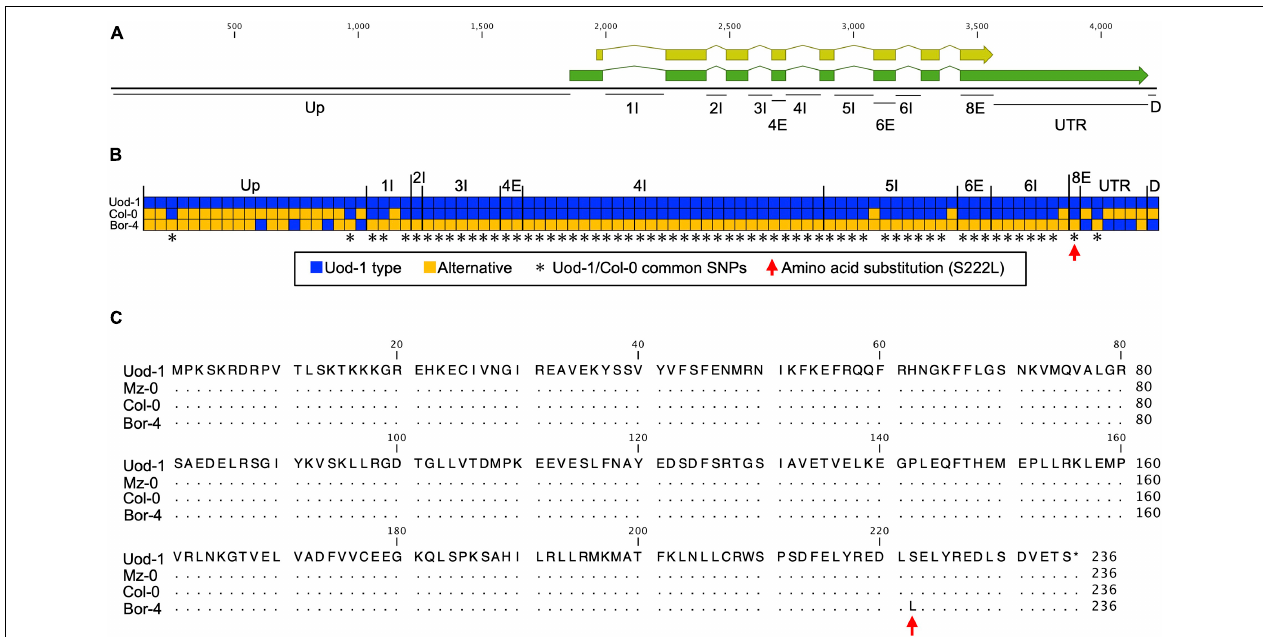
FIGURE 3 | Comparison of RDP1 sequences among Uod-1, Col-0, and Bor-4. (A) Schematic structure of the RDP1 gene. The green and yellow boxes indicate mRNA and coding regions, respectively. Up, upstream; I, intron; E, exon; UTR, 3 (cid:48) UTR; D, downstream. Each annotation was defined by NCBI information (NM_102335.4). The number with I or E stands for the ordinal number of each intron or exon. Only the names of polymorphic regions are indicated. (B) Haplotype map of the RDP1 gene. All SNPs and gaps (indels) of the RDP1 region are shown. Each box corresponds to a polymorphism. Continuous gaps (indels) are displayed as a single box. The blue box indicates the Uod-1 type, and the orange box indicates an alternative polymorphism. The asterisks indicate common SNPs between Uod-1 and Col-0. The red arrow indicates an amino acid substitution in RDP1 (S222L). The nucleic acid sequences of the RDP1 region corresponding to (A) region from Uod-1, Col-0, and Bor-4 are shown in Supplementary Figure 1 . (C) Amino acid sequences of RDP1 from Uod-1, Mz-0, Col-0, and Bor-4. Dots represent identical sequence with Uod-1. Single amino acid substitution alone was identified among these accessions (S222L, red arrow). Sequence annotations and multiple sequence alignment were generated using the CLC Main Workbench (version 21.0.5)( A,C , and Supplementary Figure 1